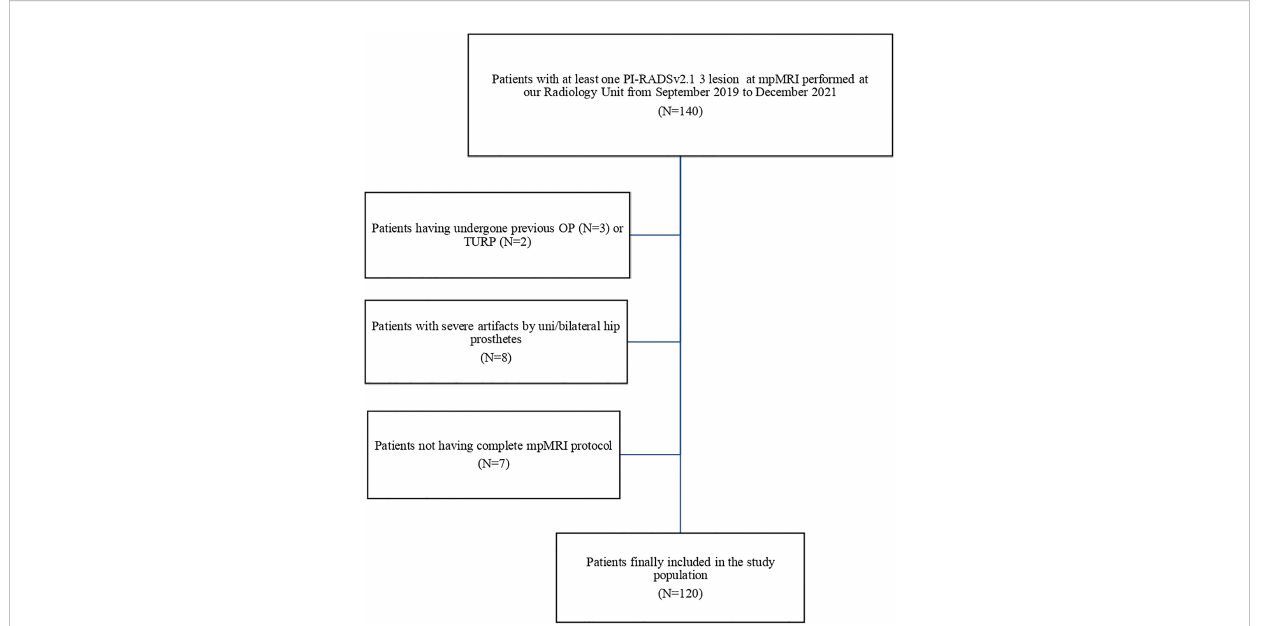
FIGURE 1 Flowchart for patient selection. PI-RADSv2.1, Prostate Imaging Reporting and Data System version 2.1; mpMRI, multiparametric Magnetic Resonance Imaging; OP, open simple prostatectomy; TURP, transurethral resection of the